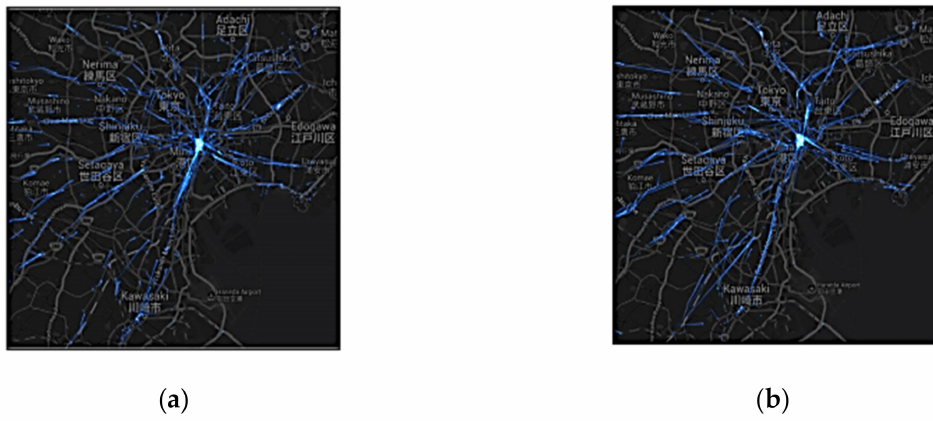
Figure 4. Regular crowd behavior: ( a ) 01 August 2011, 7–9 AM; ( b ) 02 August 2011, 7–9 AM [40].